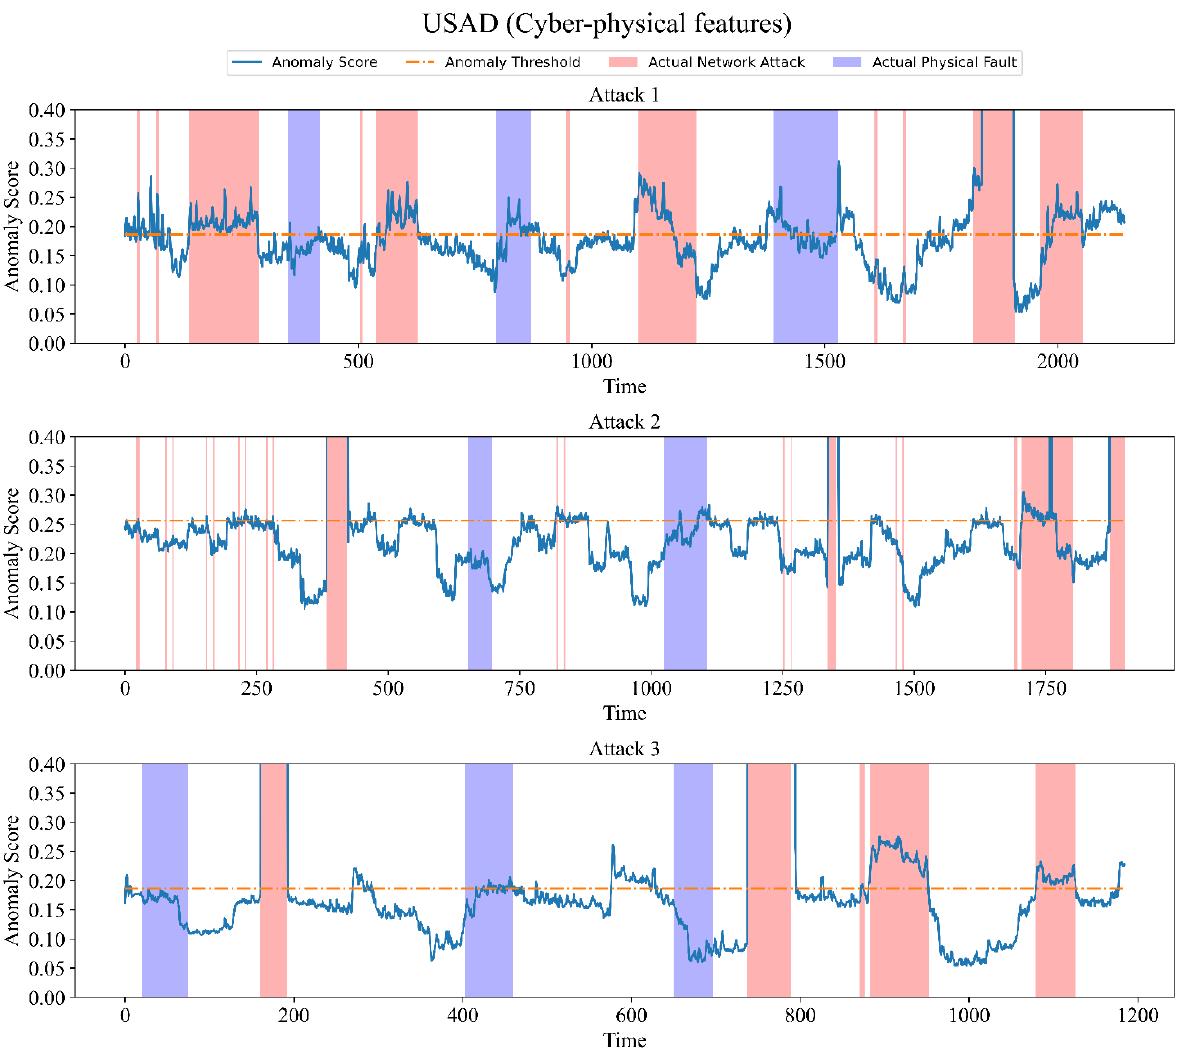
Figure 10. Anomaly scores for USAD (using network and physical features).